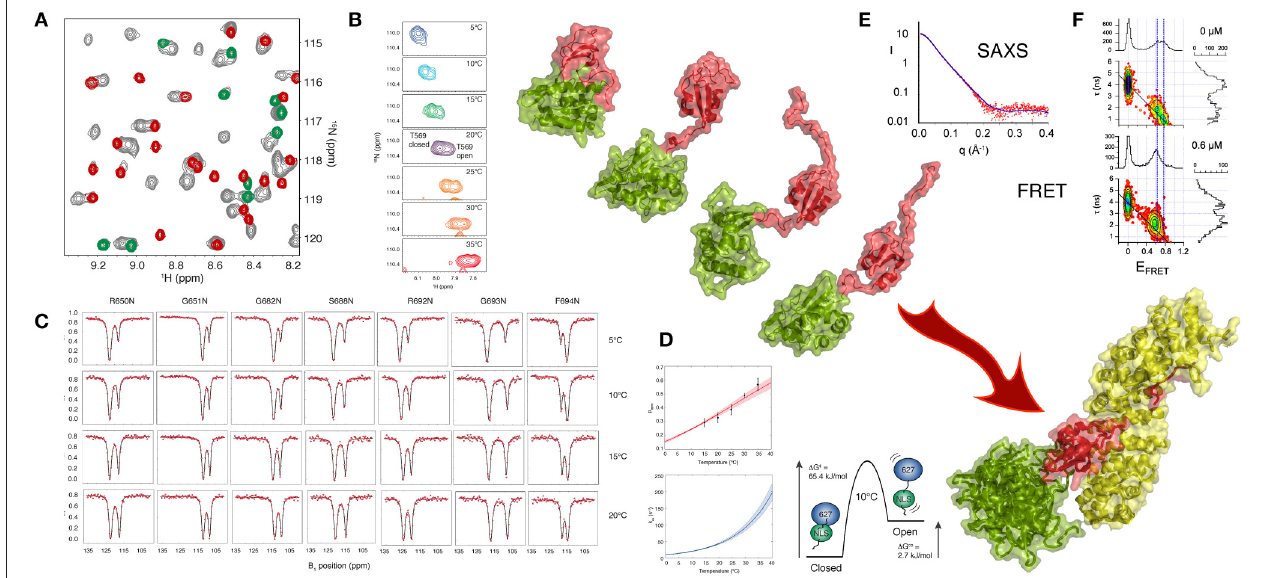
FIGURE 2 | Large Scale Conformational Dynamics Control Influenza Polymerase PB2 627-NLS domain Binding to Importin α . (A) The first evidence that the 627-NLS domain of influenza polymerase PB2 subunit samples two conformations in solution is provided by the 15 N- 1 H correlation spectrum that exhibits two sets of peaks in solution (gray), one set corresponds to resonance positions of either the free 627 (green) or the free NLS (red) domains, suggesting that the two-domain protein exchanges between open and closed forms in solution. (B) This exchange is temperature dependent, with increasing population of the open form at higher temperatures as shown in this example showing two peaks reporting on the environment sensed by T569 in the two (open and closed) forms of the protein. The majority of peaks show such behavior, with a large range of 15 N and 1 H shifts between the two forms. (C) Chemical exchange saturation transfer (CEST) of seven resolved peaks, showing “dips” reporting on the open and closed forms of the protein. (D) CEST profiles provide information about population, exchange rates and structure, and simultaneous analysis of all spectra in (C) allows for the determination of enthalpic and entropic contributions to the equilibrium thermodynamics. (E) SAXS of the complex suggests localization of the 627 domain in the vicinity of the C terminus of Importin α . (F) smFRET also shows that 627-NLS exhibits domain dynamics in the free form, and demonstrated that only the open form remains in the bound form equilibrium (concentration of titrated Importin is shown in the panels). Large-scale domain dynamics are therefore essential for binding to Importin α . (Reprinted with permission from Delaforge et al., 2015. Copyright 2015 American Chemical Society).